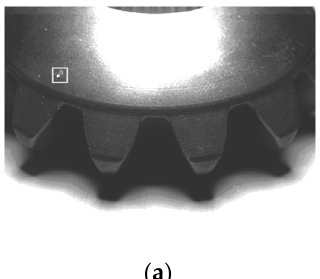
Figure 20. ( a ) The lateral image of sphere surface; ( b ) The template of sphere surface.